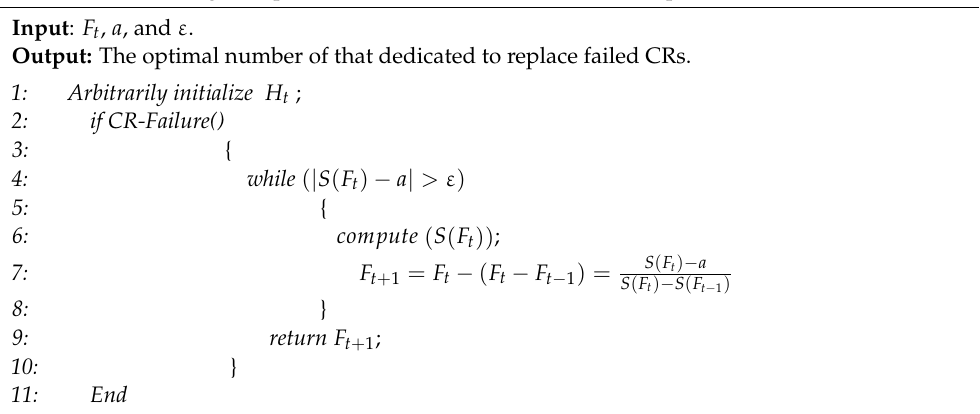
Algorithm 1 Finding the optimal number of failed machines at step t.